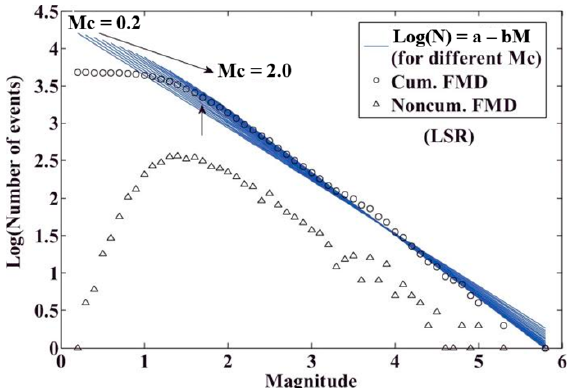
Figure 1. The effects of variations of assumed M c on b value estimation [26]. The FMD and LSR are abbreviations of frequency-magnitude distribution and least-squares regression, respectively.